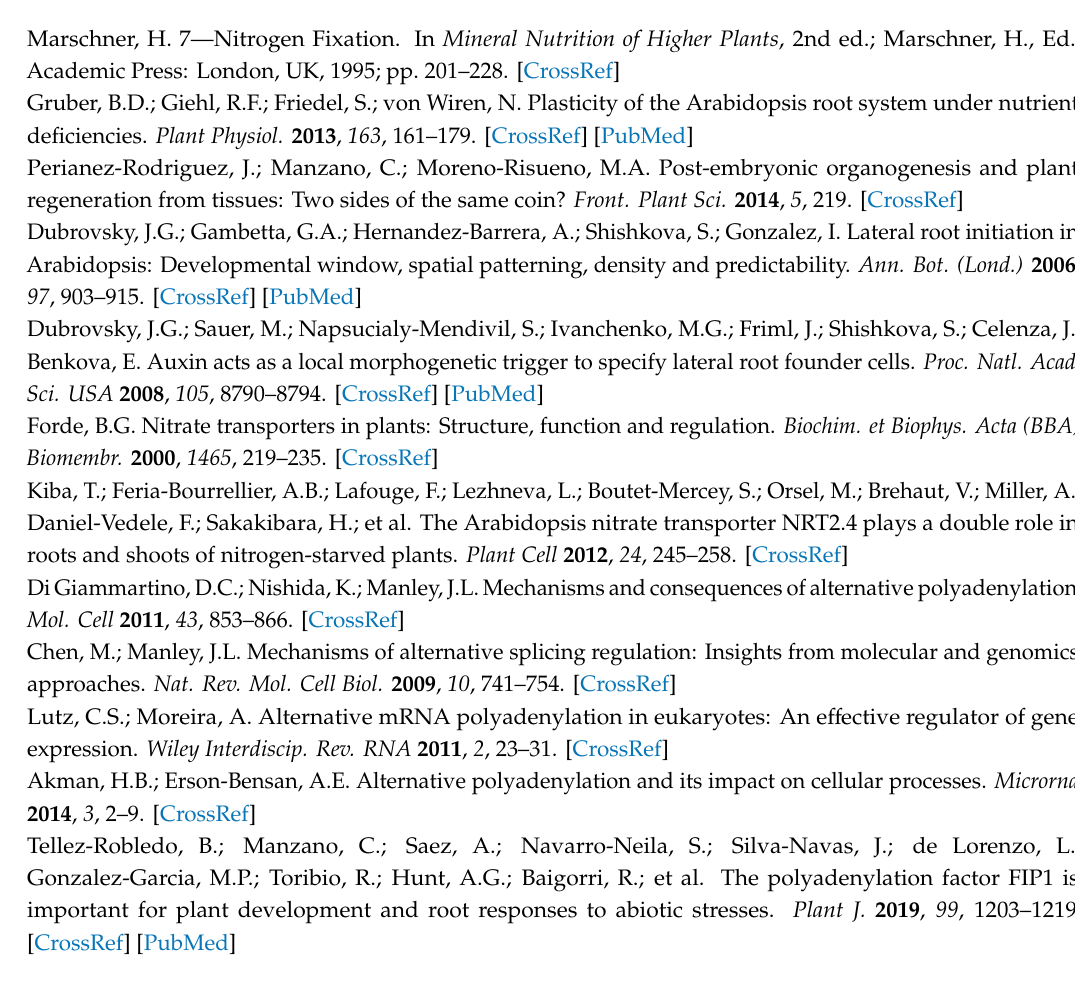
Figure S1: Expression of nitrogen response genes, Figure S2: FIP1 regulates ion accumulation, Figure S3: Hormone e ff ect on N starvation gene expression, Figure S4: Alternative PolyAdenylation of SA signaling factors, Figure S5: Common genes between SA treatment and N starvation response, Table S1: Genes modified by Alternative polyadenylation (APA), Table S2: Common genes showing APA in response to N starvation, altered expression in in fip1-2 and or by salicylic acid